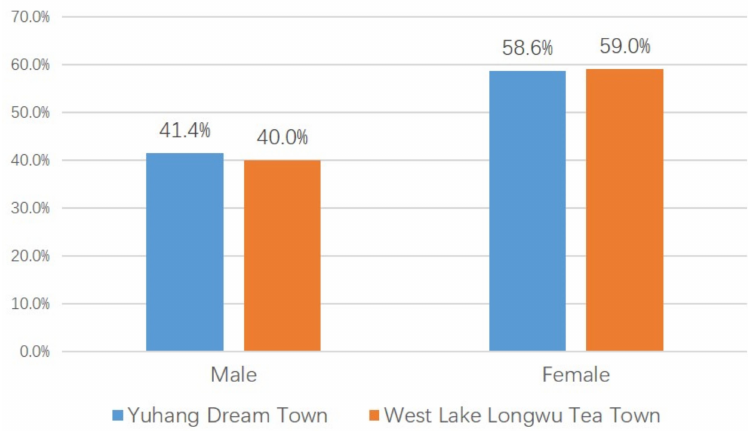
Figure 4. Gender distribution of respondents (source: